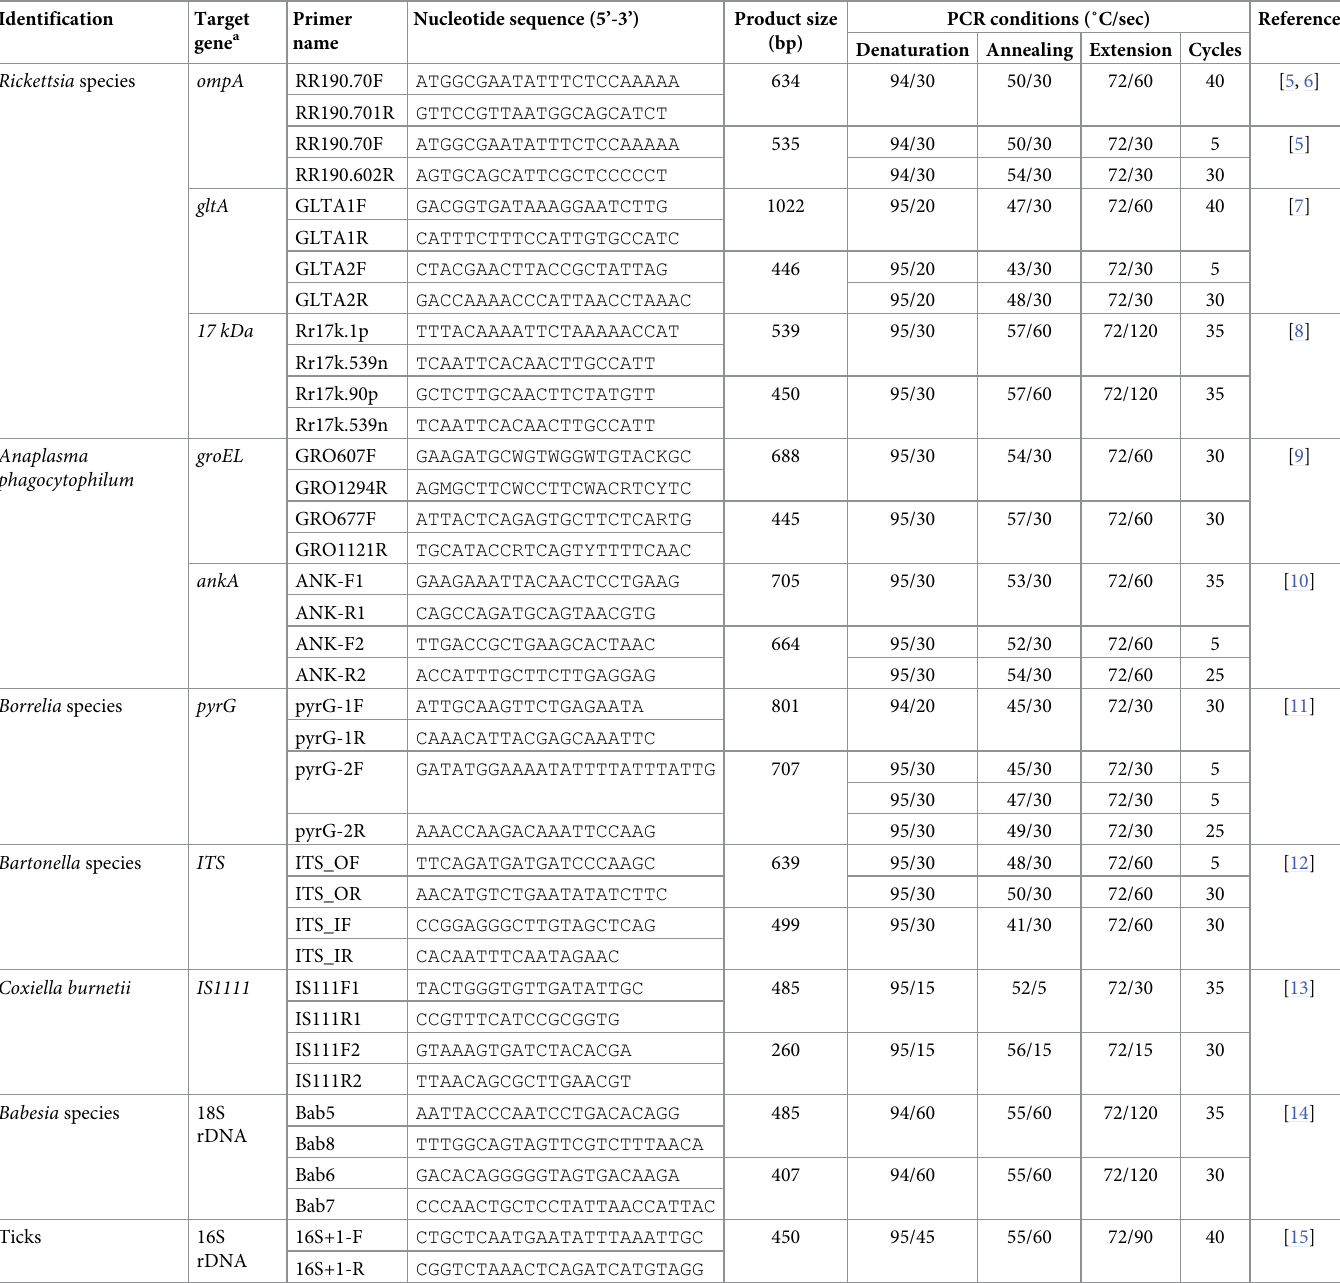
Table 1. Oligonucleotide primers and PCR conditions used for the detection of tick-borne pathogens in ticks removed from tick-bitten humans.